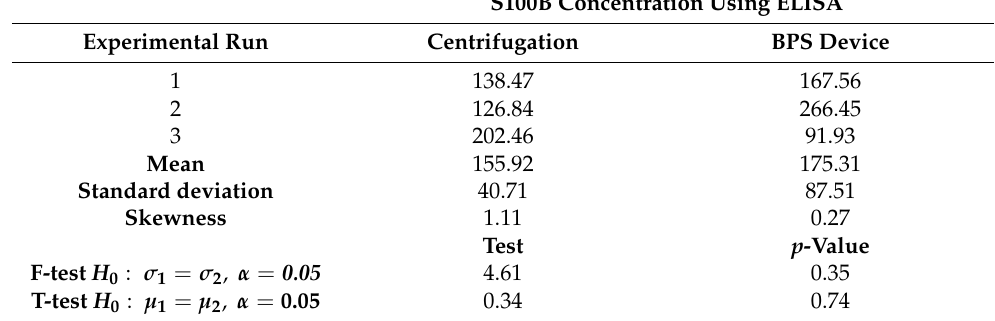
T-test H 0 : µ 1 = µ 2 , α =